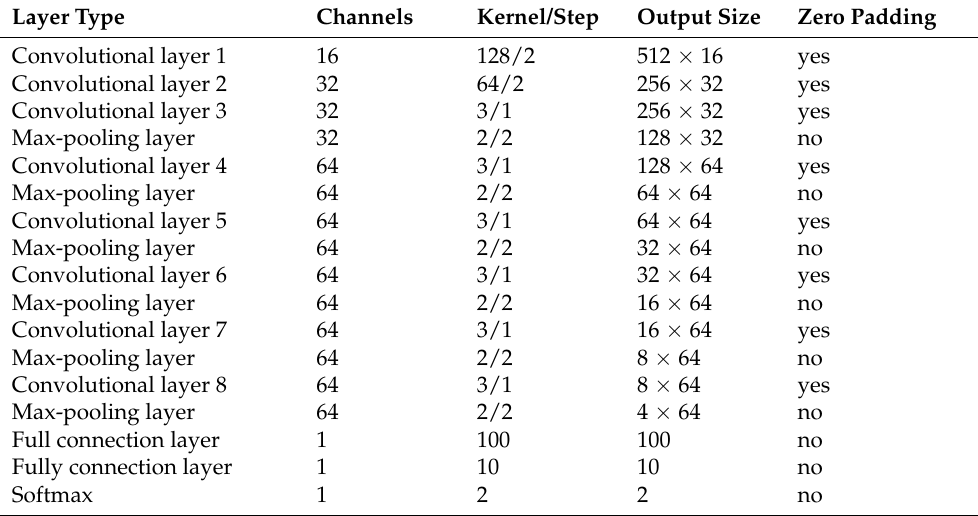
Table 3. Parameters of ITICNN.